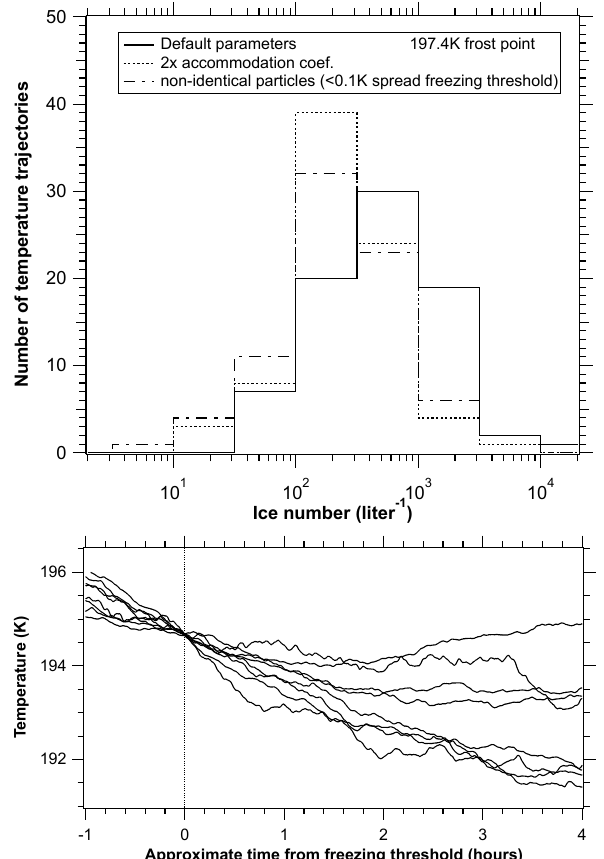
Figure 1. Histogram of ice number density generated by homoge- neous freezing in a parcel model. Also shown are the first 8 of the 80 temperature trajectories, all with same amplitude and fractal slope of temperature fluctuations. Doubling the accommodation coeffi- cient of water on the growing ice crystals systematically reduces the number density, as does assuming that there is a very small spread in the water activity at freezing. However, the phase and slope of small-scale fluctuations near the homogeneous freezing threshold creates a histogram that is much wider than the effect of changing this or other model